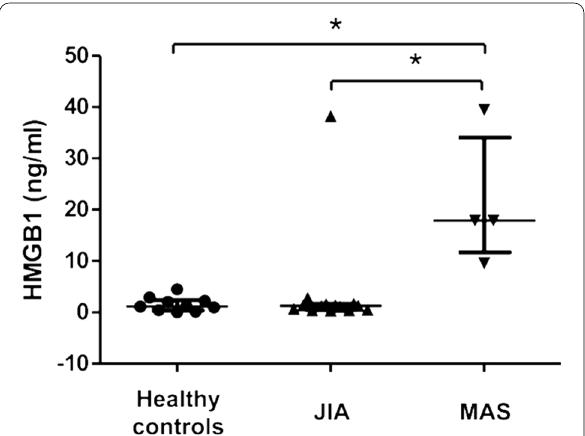
Fig. 1 High systemic HMGB1 levels in MAS patients. Plasma HMGB1 levels measured by ELISA were markedly increased during severe MAS as compared to children with uncomplicated JIA and healthy pediatric controls. The HMGB1 levels in the same cohort of JIA patients and healthy control children have been published previously in (Schierbeck et al. 2013). JIA juvenile idiopathic arthritis, MAS macrophage activation syndrome. * p <